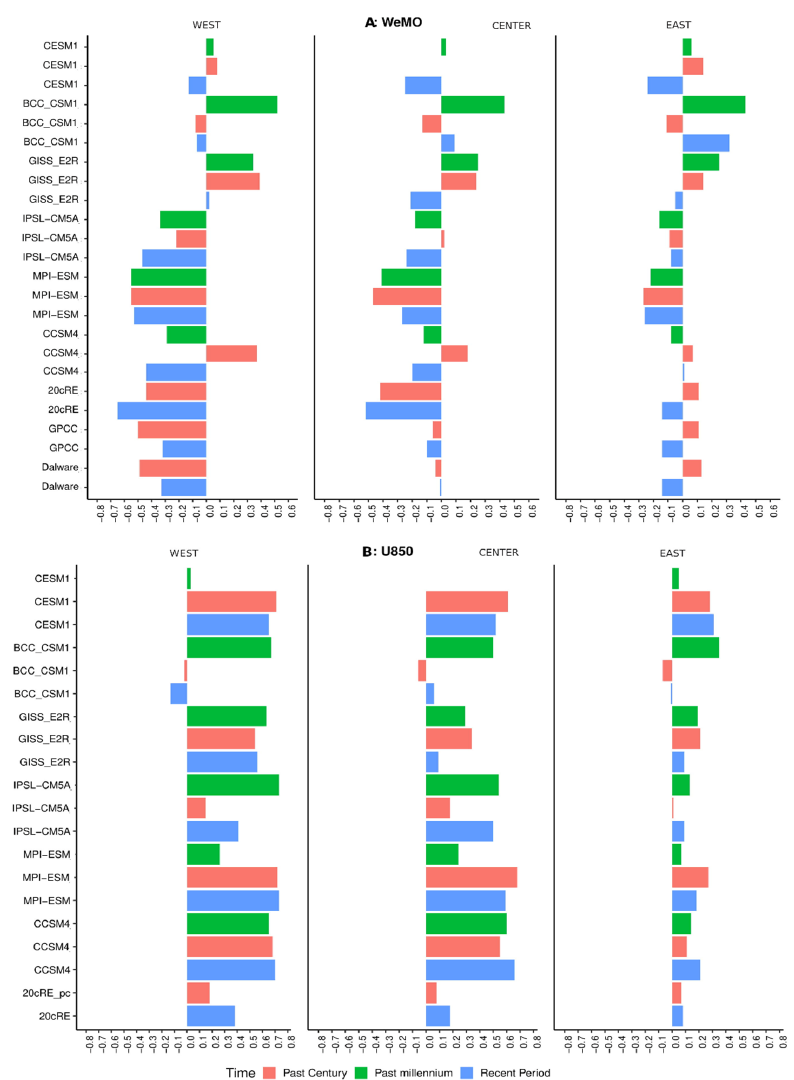
Figure 7. Pearson’s correlation coefficients between winter precipitation (observations, reanalysis, and CMIP5 simulations) and ( A ) WeMO and ( B ) U850 indices for western, central, and eastern North Africa during the recent period (1979–2005), the past century (1850–2005), and the past millennium (850–1850).